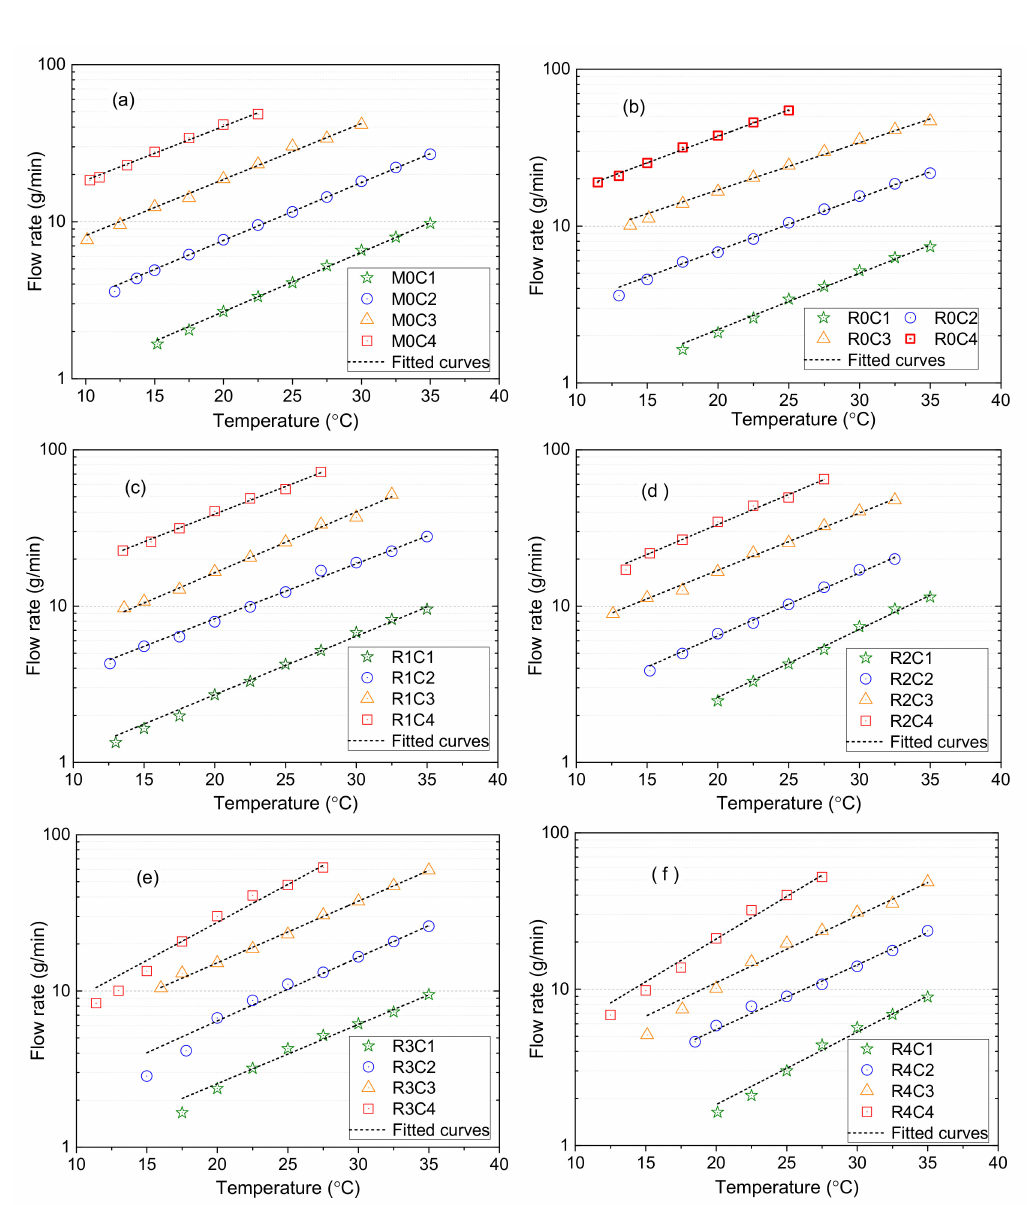
Figure 7. Fluidity test results for sealing grease with di ff erent temperatures: ( a ) M0; ( b ) R0; ( c ) R1; ( d ) R2; ( e ) R3; ( f )